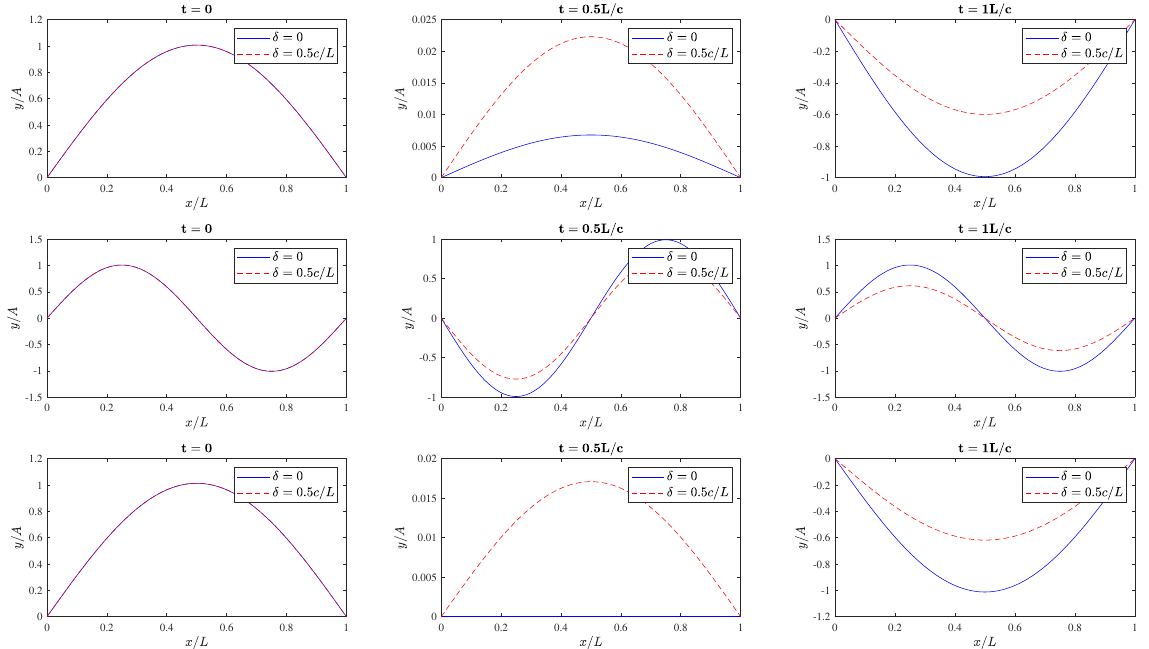
Figure 3. Total, free plus forced, non-resonant oscillations at three distinct times. The blue solid lines correspond to no damping, δ = 0, whereas the red dashed lines correspond to oscillations with damp- ing, δ = 0.5 c / L . Each row corresponds to a distinct set of values of the mode of oscillation n (which influences the value of spatial wavenumber k ) and ω : the upper row is for { n , ω } = { 1,4 π c / L } , the middle row is for { n , ω } = { 2,4 π c / L } , and the bottom row is for { n , ω } = { 1,3 π c / L } . In all the cases, the wavenumber is related to n by k = n π / L . The plots are obtained for α = 0 = β . The plots are also obtained by setting A = FL 2